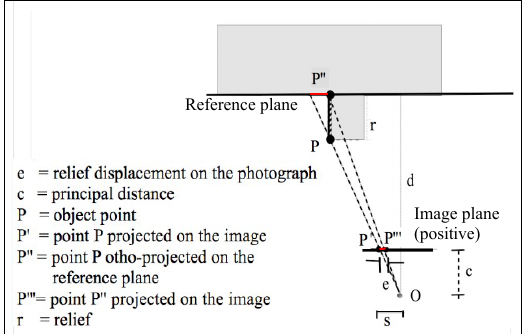
Figure 5. Relief displacement on a photograph (planimetric projection)